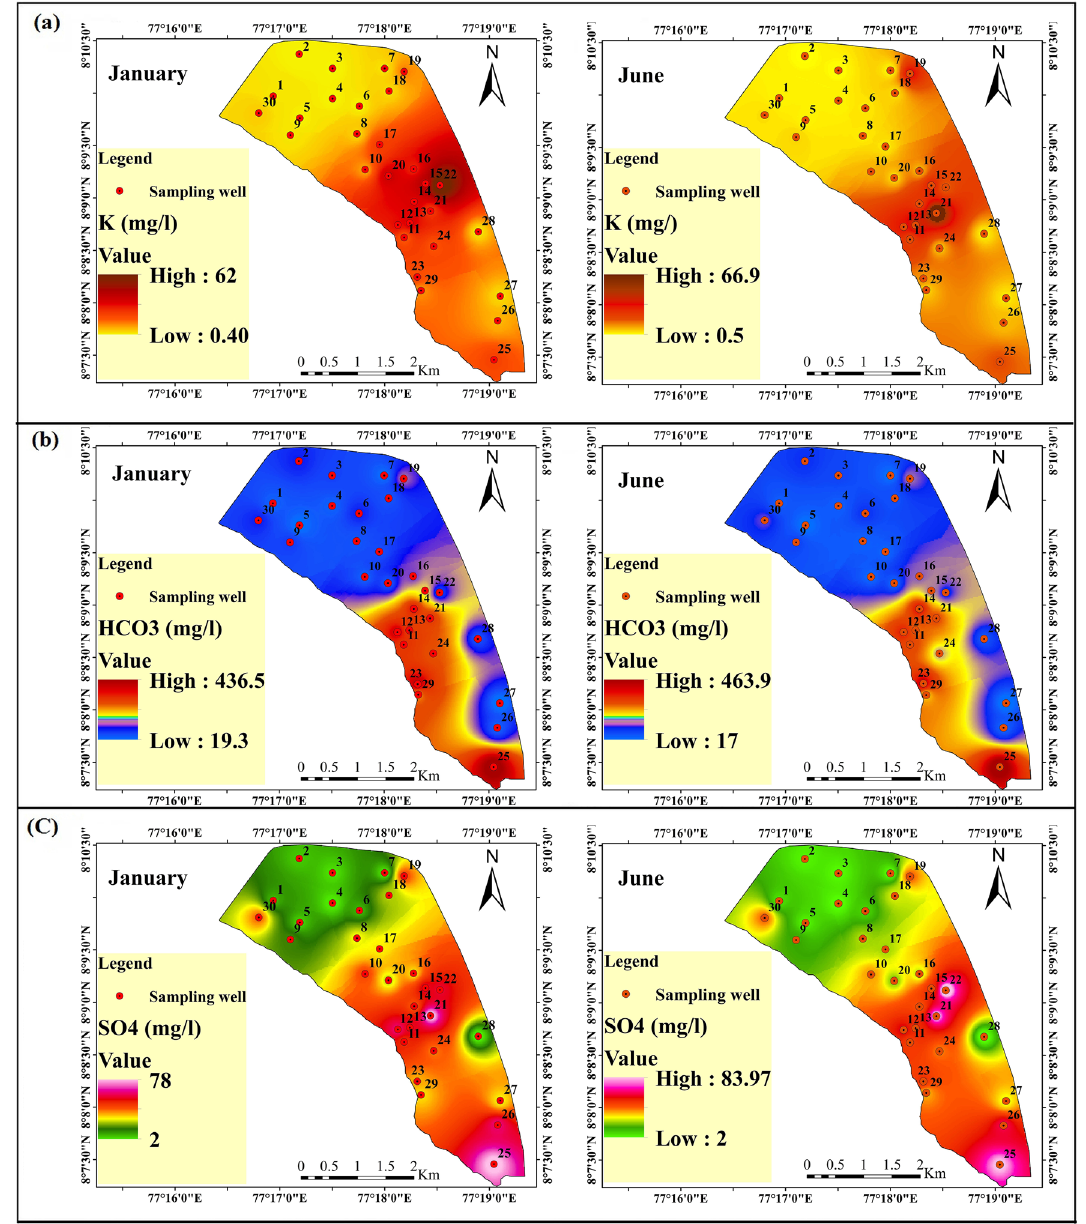
Fig. 5 a Spatial distribution of K + in the study area, b spatial distribution of HCO 3− in the study area, c spatial distribution of SO 42– in the study